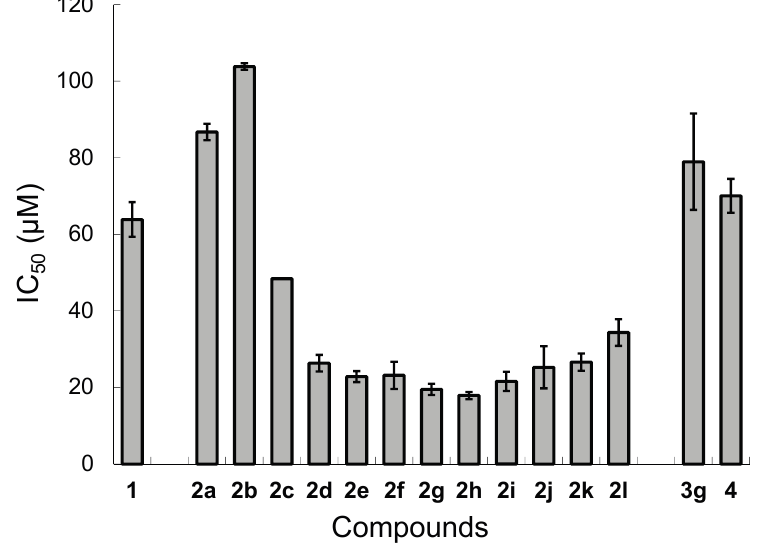
Figure 1. 50% inhibitory concentrations (IC 50 ) for DHS ( 1 ), C 3 ( 2a ), C 6 ( 2b ), C 8 ( 2c ), C 10 ( 2d ), C 11 ( 2e ), C 12 ( 2f ), C 13 ( 2g ), C 14 ( 2h ), C 15 ( 2i ), C 16 ( 2j ), C 17 ( 2k ), C 18 ( 2l ), C 13 -di ( 3g ), and PhSeSePh ( 4 ) against lipid peroxidation of soybean lecithin/cholesterol liposome. AAPH (3.1 mM) was used as a hydrophilic radical initiator. The assay conditions were at pH 7.4 and 37 °C for 3 h. Error bars are given as standard deviations. The data for 1 , 2a , 2f , 2h , 2j , 2l , and 4 were quoted from Ref. [12]. Copyright Wiley-VCH Verlag GmbH & Co. KGaA. Reproduced with